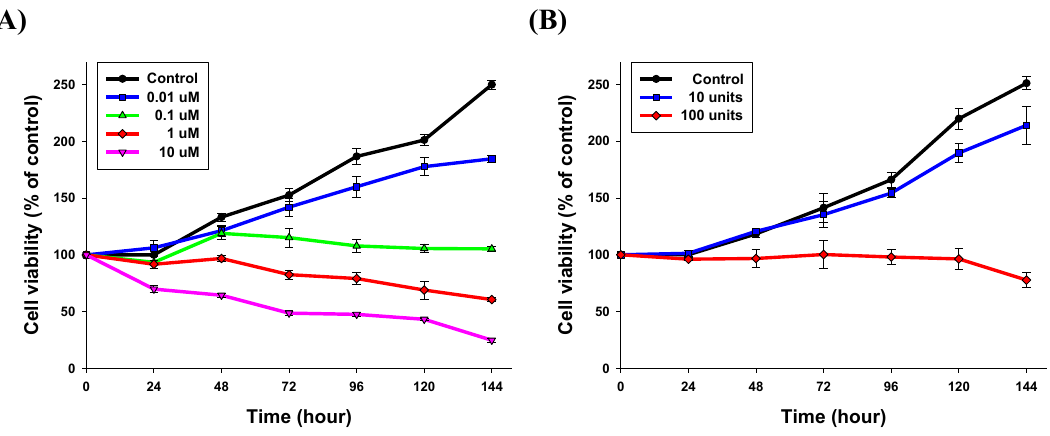
Figure 6. Evaluation of time-related drug release efficiency. ( A ) As a control, lapatinib solution was used in the MTT assay for 24 to 144 h; ( B ) With the 40 μm microstructures, the cell growth inhibitory efficiency was measured with varying numbers of units (10 and 100 units) until 144